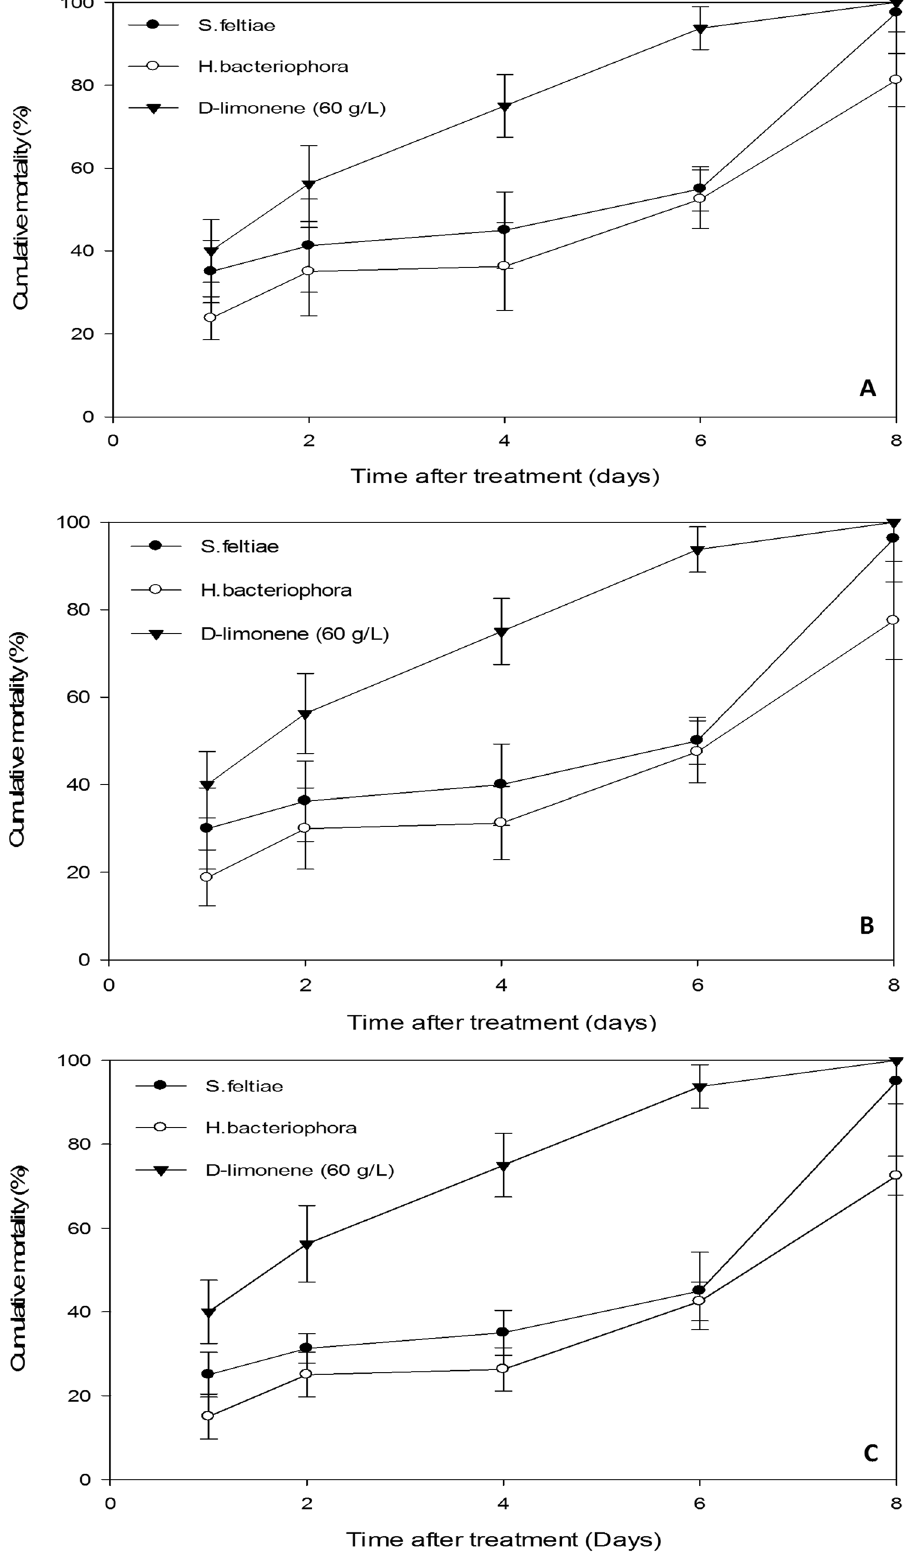
Figure 4. Cumulative mortality of Dactylopius opuntiae adult’s female by Steinernema feltiae and Heterorhabditis bacteriophora with different concentrations ( A —75, B —50, C —25 IJs cm −2 ) according to days after treatment. Vertical bars indicate standard